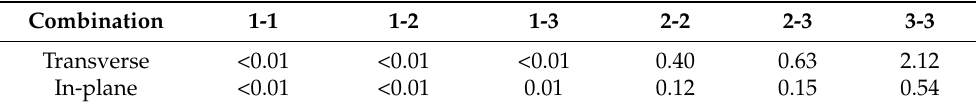
Table 1. Maximum transverse and in-plane representation error (in %) of the dual data by the 3L6D basis. Cantilevered curved